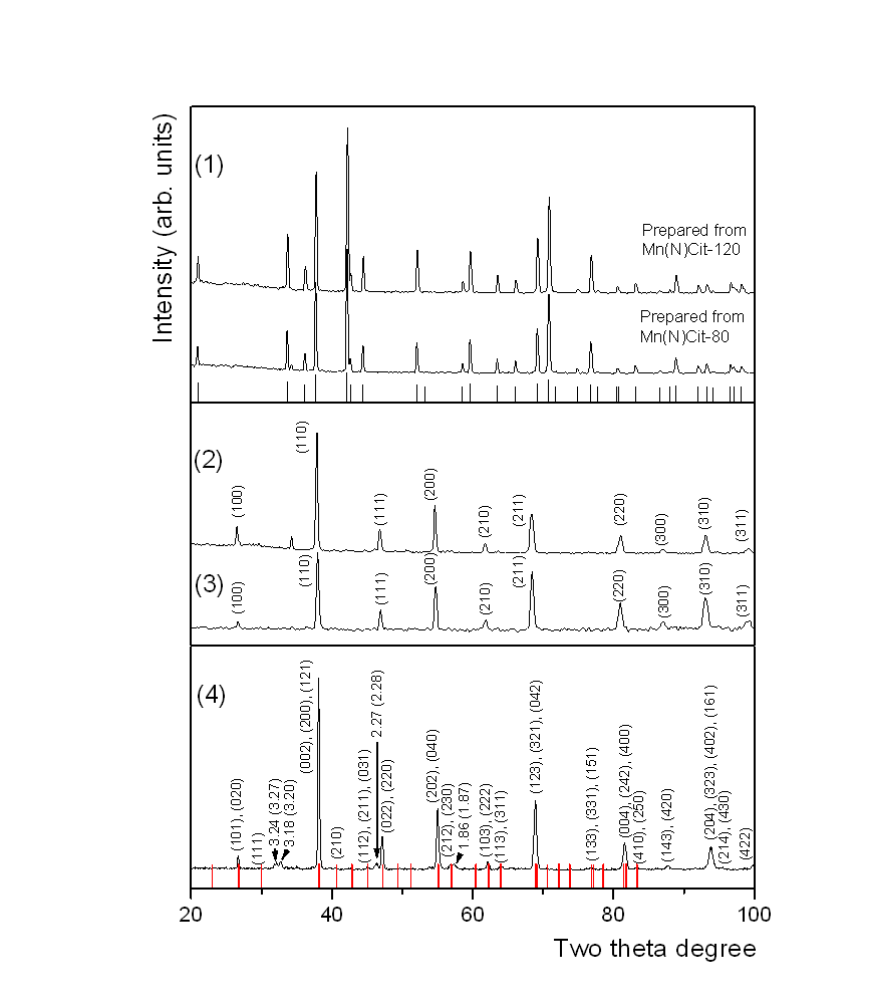
Fig. 5 X-ray-diffractograms of the products obtained at: heating for 2.5 h at 1000 ◦ C of Mn(N)Cit-80 and Mn(Cl)Cit-120 (1) (the bars represent the reflections of Mn 3 O 4 according to JCPDS 24-0734); heating for 2.5 h at 1000 ◦ C of LaMn(N)Cit-60 (2) and LaMn(Cl)Cit-120 (3) (Miller indexes for LaMnO 3 are shown according to JCPDS 75-0440); heating the LaCaMn - citrate at 450 ◦ C (1 h) and 1200 ◦ C (2 h) (4) (the bars represent the position of the reflections of La 0 . 7 Ca 0 . 3 MnO 3 according to ICSD 88398, Miller indexes are shown). Interplanar distances (d, ˚A) of the reflections ascribed to La 2 CaO x are shown (in brackets – the same distances according to JCPDS